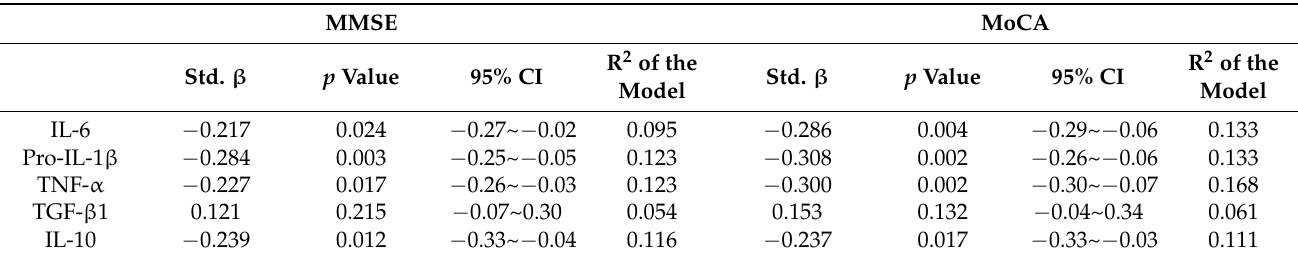
Table 3. Association of plasma extracellular vesicle cytokine levels with the cognition in Parkinson’s disease patients after adjusting for age and sex.